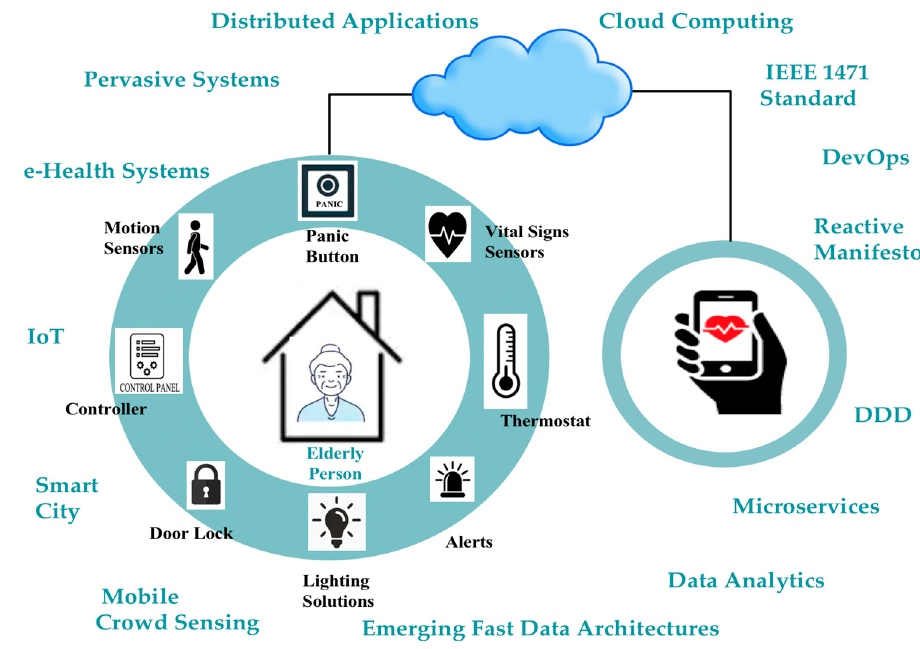
Figure 1. Information and communications technology for health services.